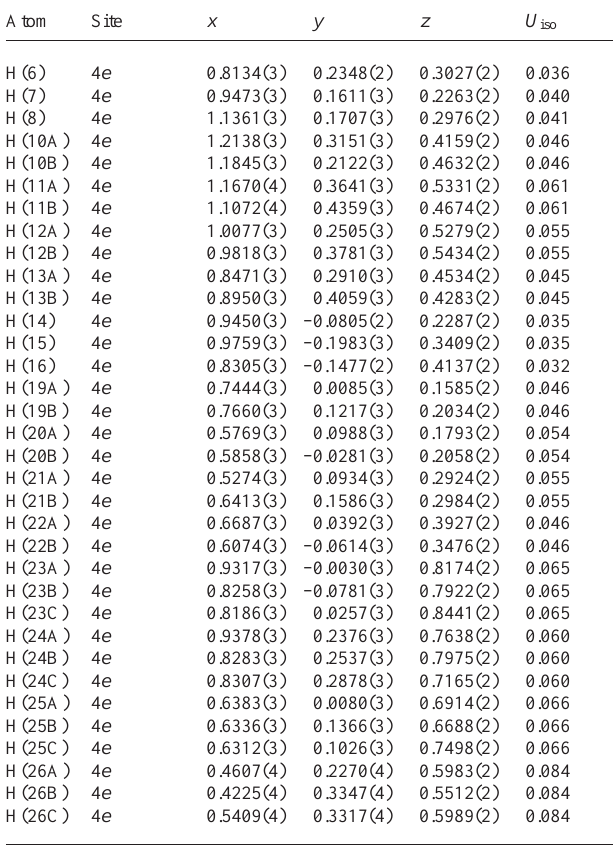
Table 2. Atomic coordinates and displacement parameters (in Å 2 )